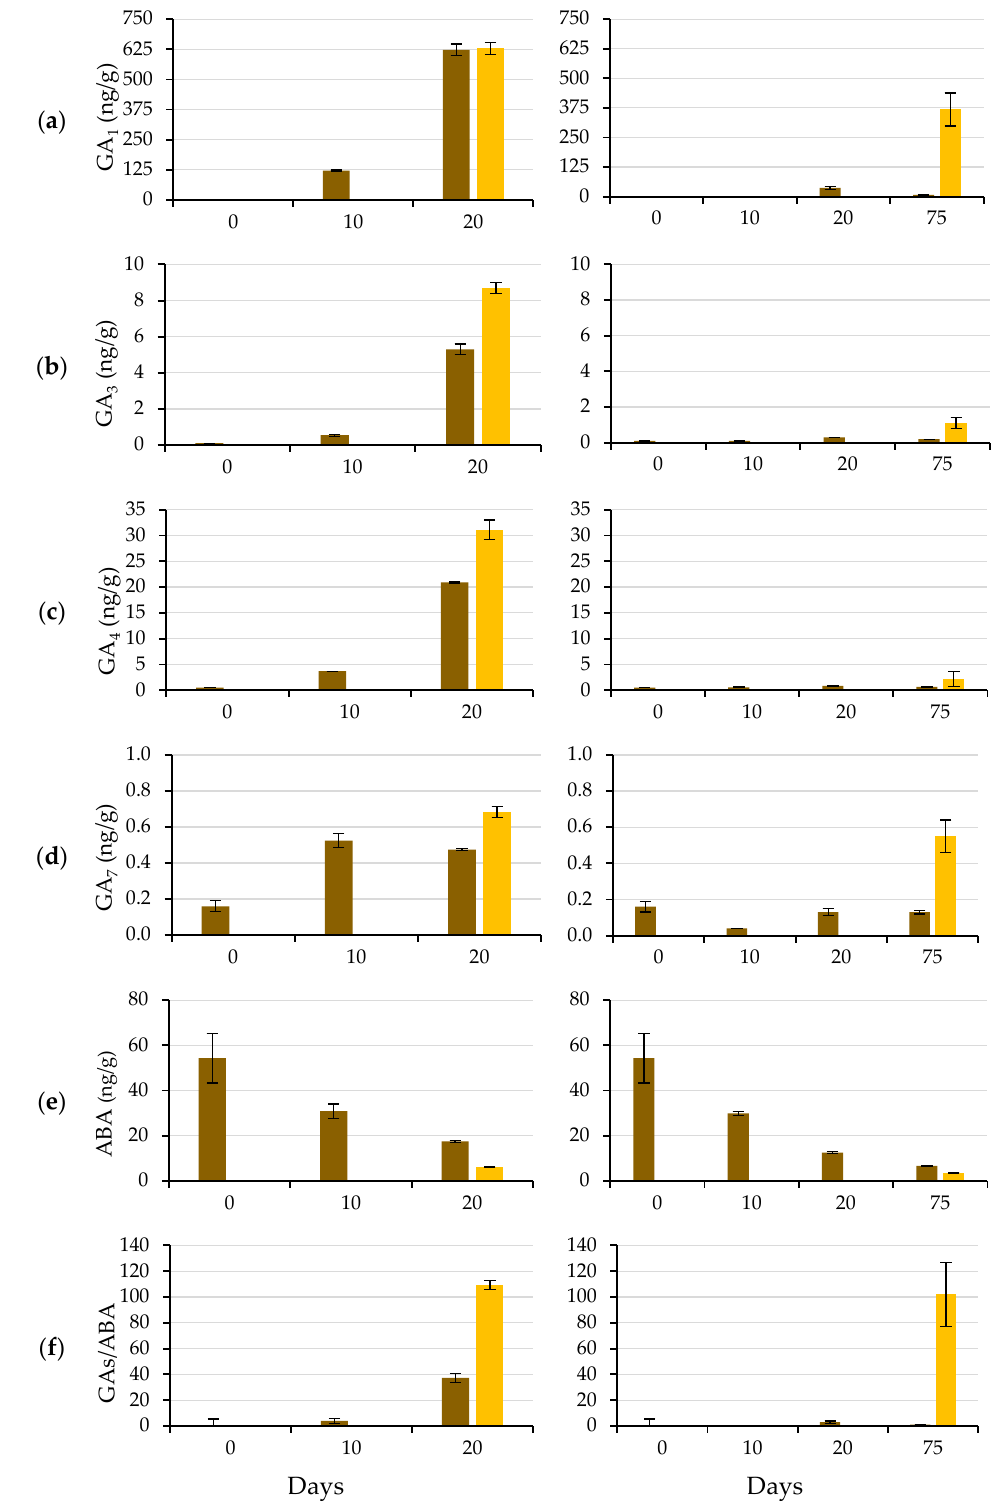
Figure 7. GA 1 ( a ), GA 3 ( b ), GA 4 ( c ), GA 7 ( d ) and ABA ( e ) contents and the GAs/ABA ratio ( f ) at 0, 10, 20 and 75 (if applicable) days after of the start of the germination test, using a GA 3 (500 mg L − 1 ) solution (left) or water (right) to wet the substrate. Day 20 (75) corresponds to the protrusion of the radicle of the seeds wetted with GA 3 (water). Non-germinated seeds in brown, and germinated seeds in yellow. Mean values ± SE of 40 seeds (two replicates of 20 seeds).